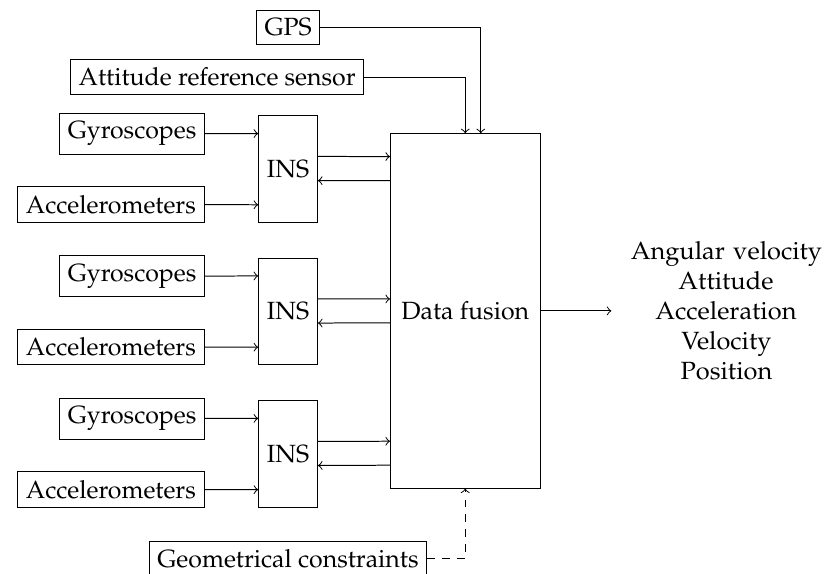
Figure 2. Fusion structure of three INSs.